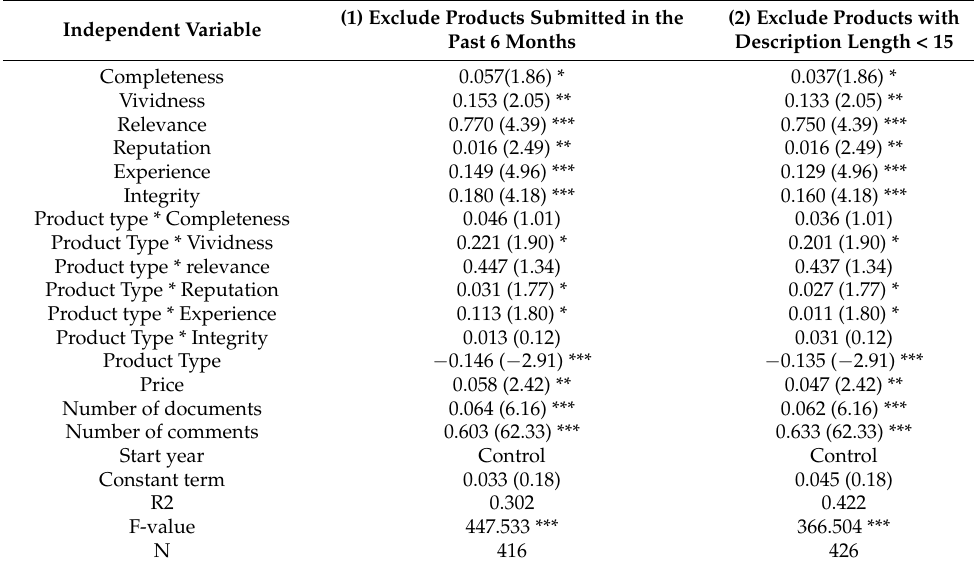
Table 8. Results of Robustness